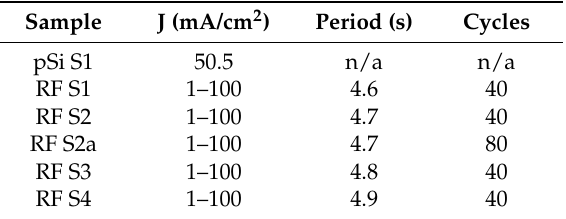
Table 1. Preparation conditions for all used